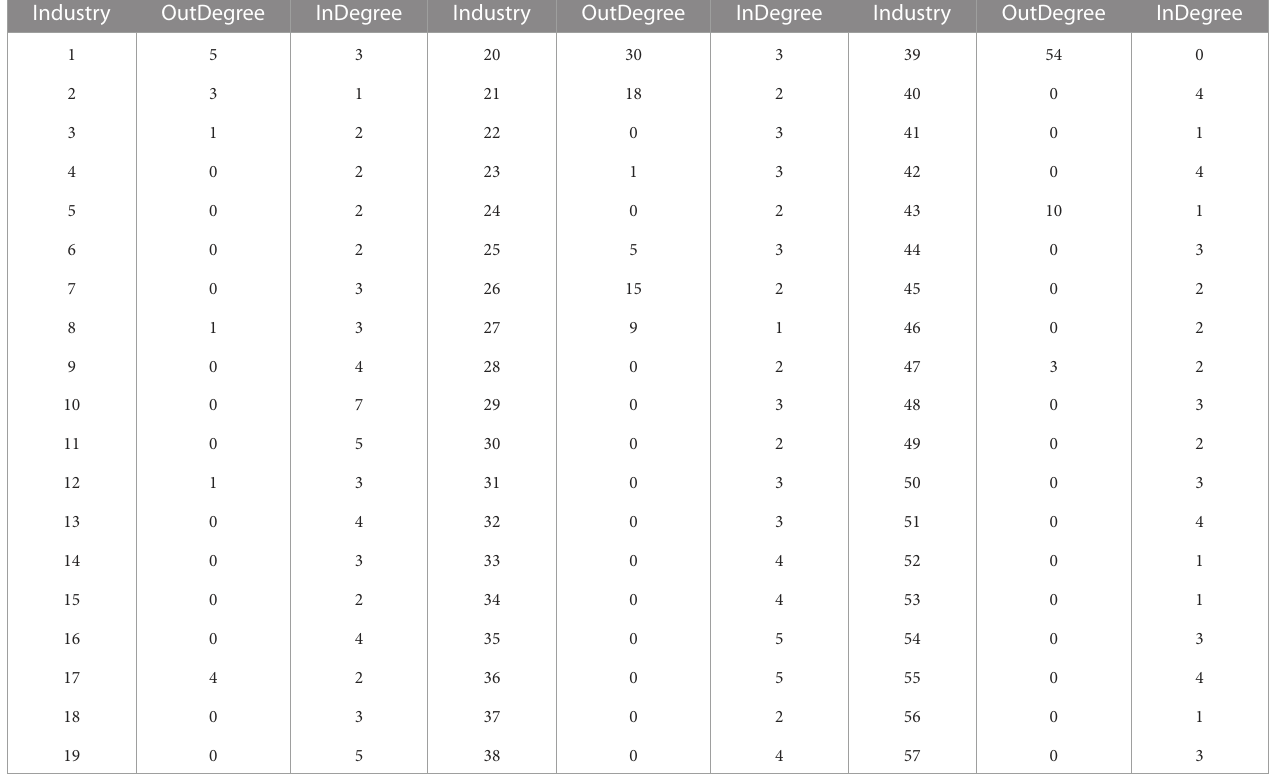
TABLE5 Out-degreeandin-degreeofeachindustry.